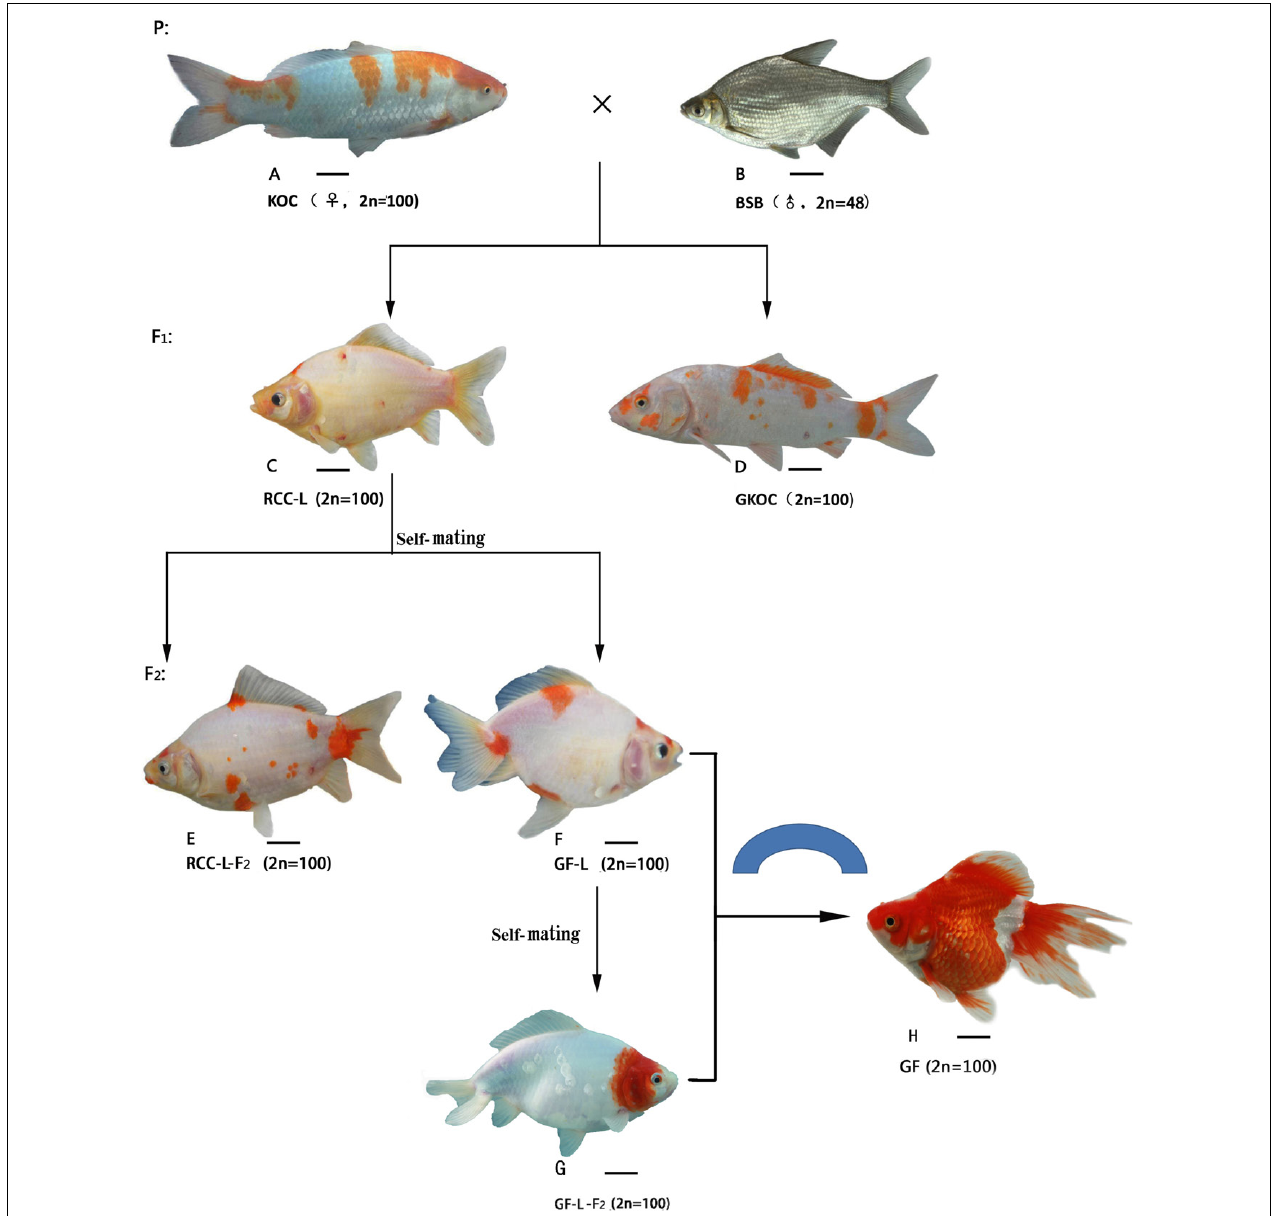
FIGURE 1 | The formation procedure and the appearance of KOC, BSB, RCC-L, GKOC, GF-L, GF-L-F 2 and GF. (A) KOC; (B) BSB; (C) RCC-L; (D) GKOC; (E) RCC-L; (F) GF-L; (G) GF-L-F 2 ; and (H) GF. Bar = 3 cm.